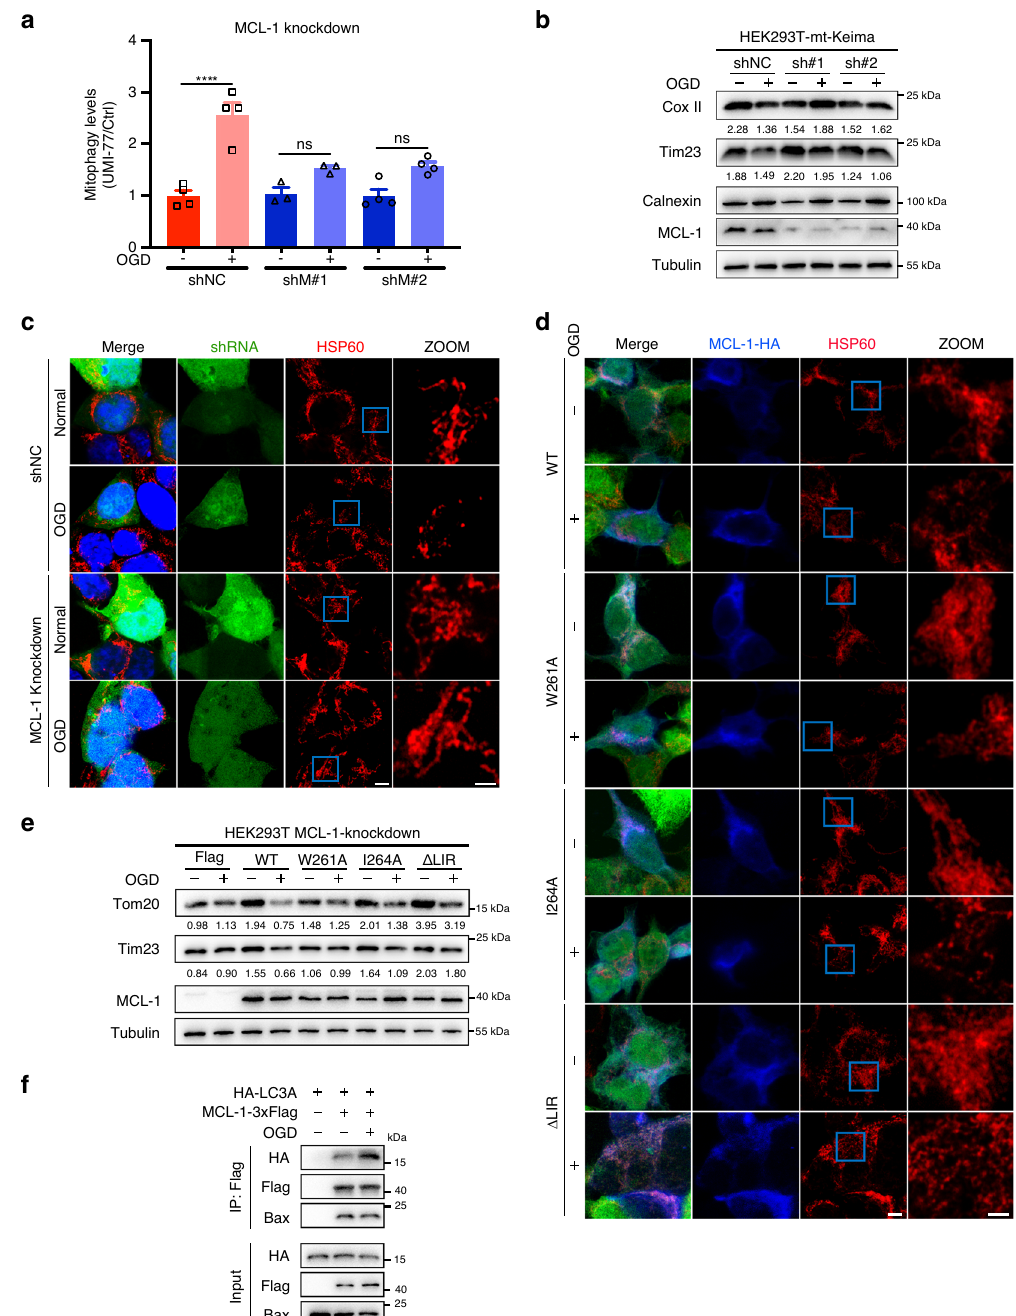
Fig. 5 MCL-1 is required for mitophagy induced by oxygen-glucose deprivation. a HEK293T-mt-Keima cells were infected with lentiviral particles encoding MCL-1 shRNA for 24 h and treated with oxygen-glucose deprivation (OGD) for 5 h. Mitophagy levels were analyzed by one-way ANOVA (data represent mean ± S.E.M.; n = 4. **** p < 0.0001, ns, not signi fi cant). shNC: scrambled shRNA. b HEK293T-mt-Keima cells were infected with lentiviral particles encoding MCL-1 shRNA for 24 h and treated with OGD for 5 h. Cell lysates were immunoblotted with indicated antibodies. The numbers under the blots represent the gray scale quanti fi cation (Cox II/Tubulin, Tim23/Tubulin). shNC: scrambled shRNA. c HEK293T cells were infected with lentiviral particles encoding MCL-1-shRNA or control-shRNA for 24h, treated with OGD for 5 h. Cells were fi xed and stained with indicated antibodies. Green channel indicated cells were infected successfully. Scale bar, 5 μ m; insets: scale bar, 2 μ m. shNC: scrambled shRNA. d HEK293T-MCL-1-knockdown cells were transfected with MCL-1 wild-type or indicated mutants for 24 h, treated with OGD for 5 h. Cells were fi xed and stained with indicated antibodies, following by fl uorescence microscopy analysis. Scale bar, 5 μ m; insets: Scale bar, 2 μ m. e HEK293T-MCL-1-knockdown cells were transfected with MCL-1 WT or indicated mutants for 24 h, treated with OGD for 5 h. Cell lysates were immunoblotted with indicated antibodies. The numbers under the blots represent the gray scale quanti fi cation (Tom20/Tubulin, Tim23/Tubulin). f HEK293T cells were co-transfected with MCL-1-3xFlag and HA-LC3A for 24 h, treated with OGD for 5 h, and the interaction of Flag-tagged MCL-1 with HA-LC3A and endogenous Bax was analyzed by immunoprecipitation. Source data are provided as a Source Data fi